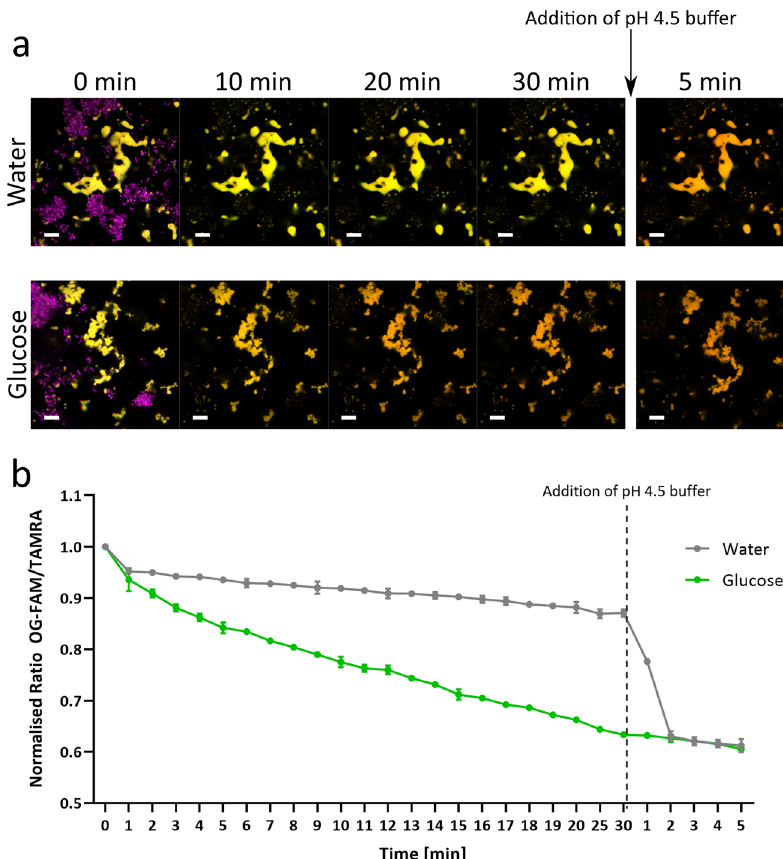
Fig. 7 Reduction in fl uorescence intensity is a result of glucose metabolism over time in bio fi lms of S. mutans . Bio fi lms of S. mutans NCTC 10832 were initially imaged after 48 h of static growth before either water or 1% glucose was added to the bio fi lm. Further images were taken every minute for 20 min, and then at 25 and 30 min. After 30 min, a 4.5 pH buffer was added and further images were taken every minute for 5 min. a 3D top view fl uorescent microscope image of the fl uorescence intensity changes over time. Green (OG-FAM), red (TAMRA) fl uorescence with time point 0 min including DAPI-stained S. mutans cells shown in magenta. Scale bar represents 10 µm. b Fluorescence intensity of OG-FAM and TAMRA was measured using wide- fi eld images in ImageJ and the normalised ratio is plotted against the time of incubation. Error bars represent standard error measured for different bio fi lm replicates, where n =